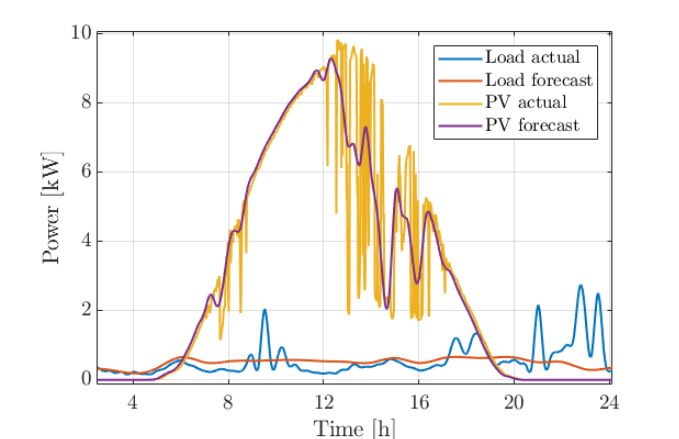
Figure 2. Example of the resulting PV and load forecasts and the actual powers for a summer